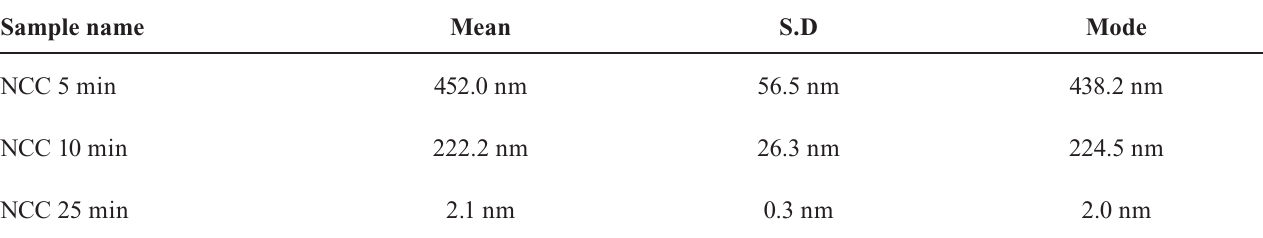
TABLE IV - Particle size measurement NCC with different ultrasonic time